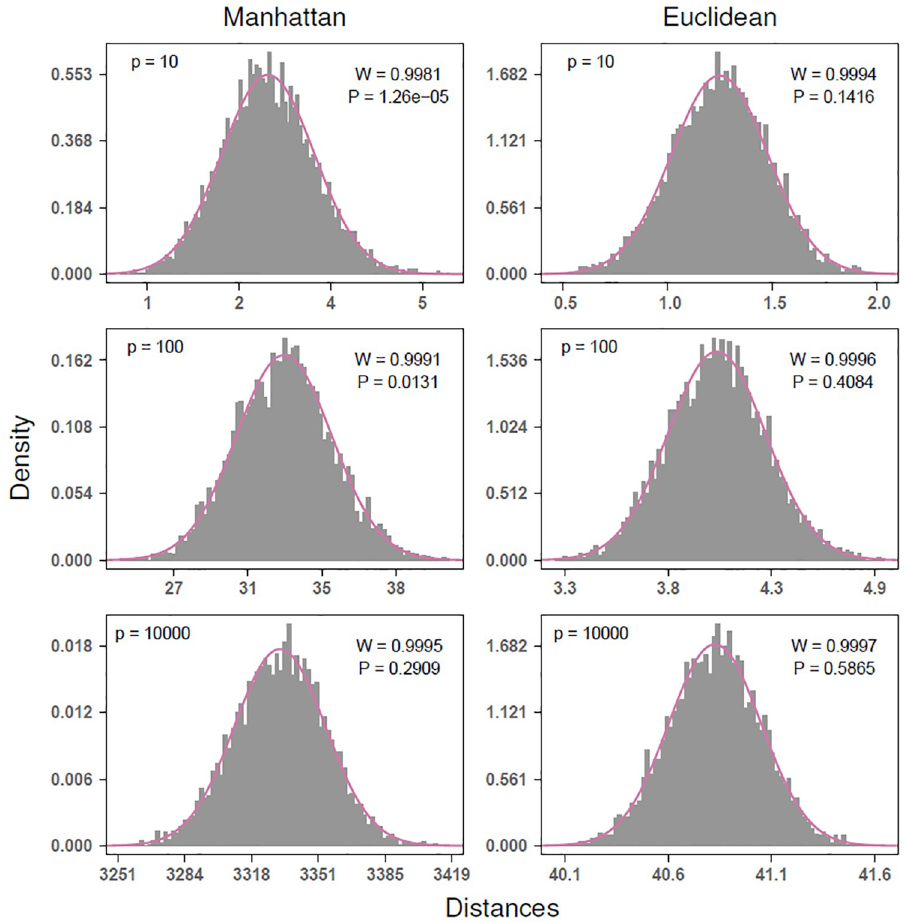
Fig 1. Convergence to Gaussian for Manhattan and Euclidean distances for simulated standard uniform data with m = 100 instances and p = 10, 100, and 10000 attributes. Convergence to Gaussian occurs rapidly with increasing p , and Gaussian is a good approximation for p as low as 10 attributes. The number of attributes in bioinformatics data is typically much larger, at least on the order of 10 3 . The Euclidean metric has stronger convergence to normal than Manhattan. P values from Shapiro-Wilk test, where the null hypothesis is a Gaussian distribution.